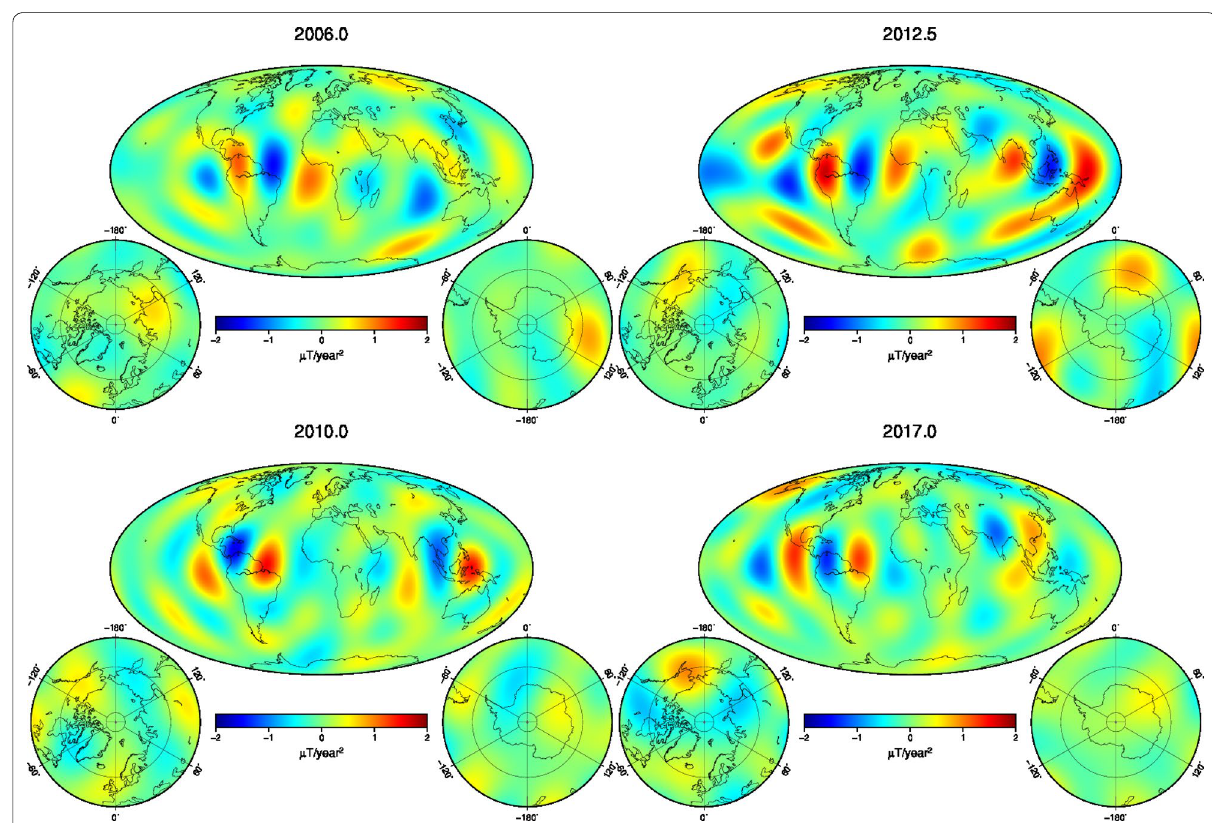
Fig. 12 Model A spatial maps of d 2 B r / dt 2 at the core mantle boundary to spherical harmonic degree 8 for epochs 2006.0, 2010.0, 2012.5, and